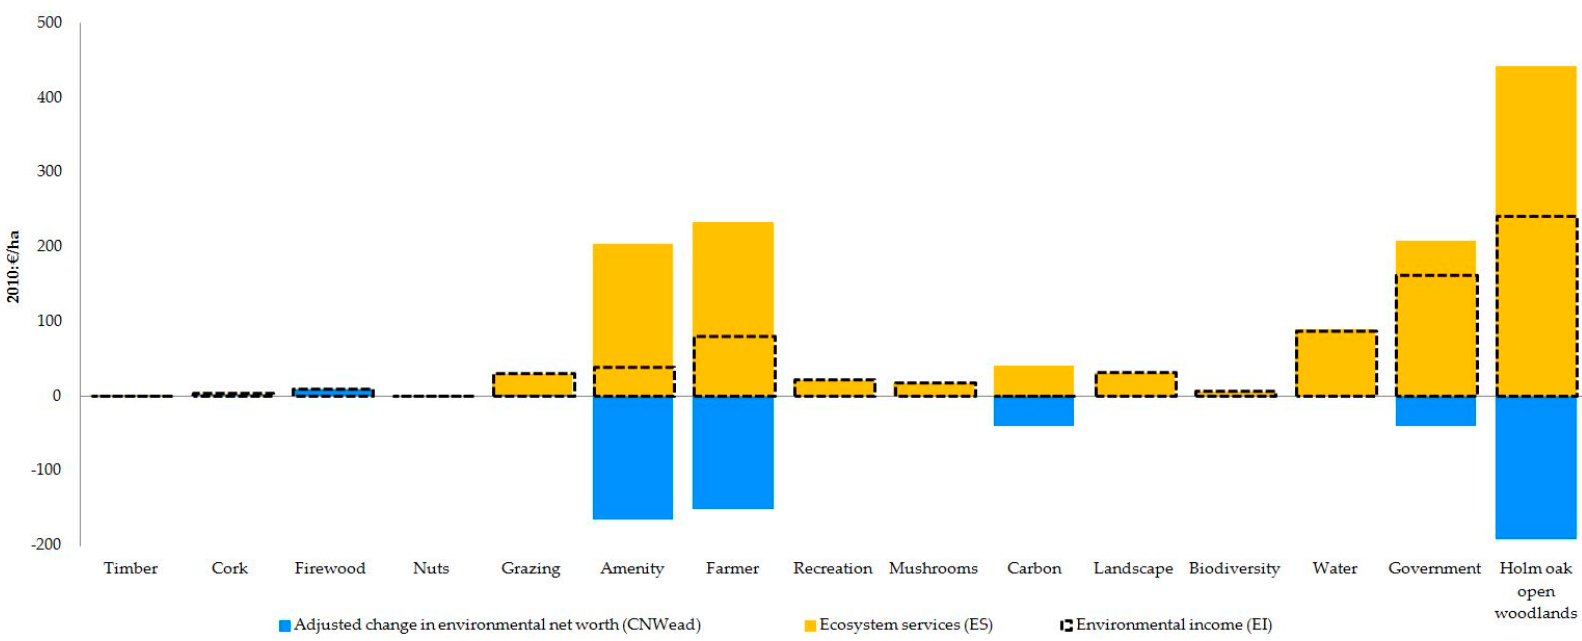
Figure 6. Agroforestry Accounting System ecosystem services change in environmental net worth adjusted according to WPeu and environmental incomes at social prices for holm oak open woodlands in Andalusia (2010: €/ha). The briefly described sequences of accounts are repeated in the application of the rSNA to the holm oak open woodlands of Andalusia (Tables S8, S9, and A1 on Appendix B).